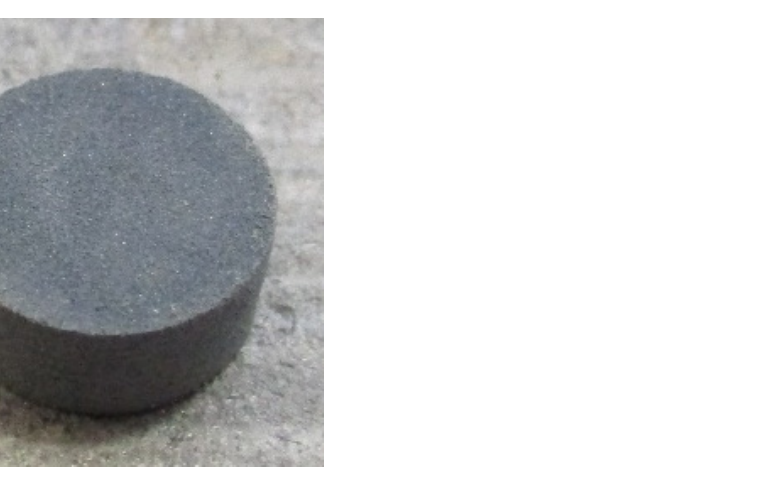
Figure 7. Example of the thermophysical sample (12.7 mm diameter and 5 mm thickness). Table 5. Parameters and conditions of the thermophysical characterization carried out through the Light Flash Apparatus. Temperature Range ( ◦ C) Temperature Steps ( ◦ C) Inert Atmosphere Heating Rate (K/min) 25–1000 ◦ C 100-(11 experimental points) Argon Table 6. Thermophysical properties of the untreated samples. Average values of the two samples.